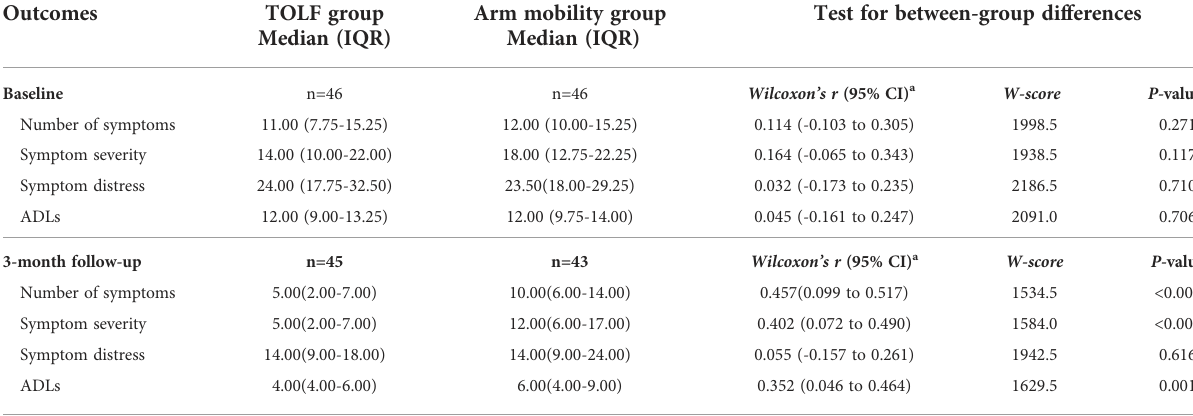
TABLE 3 Comparison of symptom experience and ADLs between the TOLF intervention group and arm mobility control group at baseline and study endpoint.